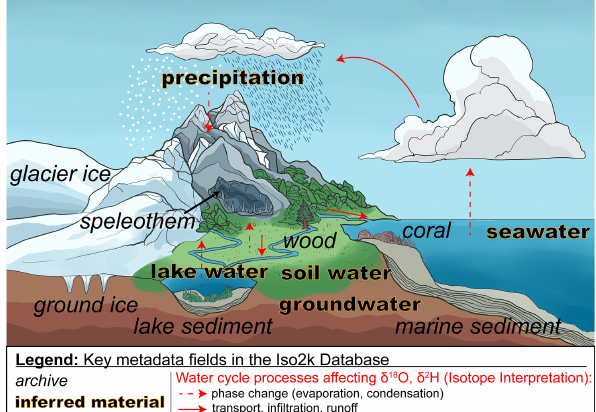
Figure 1. Schematic illustration of the global water cycle and key metadata fields in the Iso2k database. In the Iso2k database, the histories, including phase changes and transport (“Isotope Interpre- tation”; red text and arrows), of different pools of environmental waters (“Inferred Material”; bold text) can be inferred by interpreta- tion of proxy records from different archives (“Archive”; italic text). Base illustration by Helen Xiu, Washington